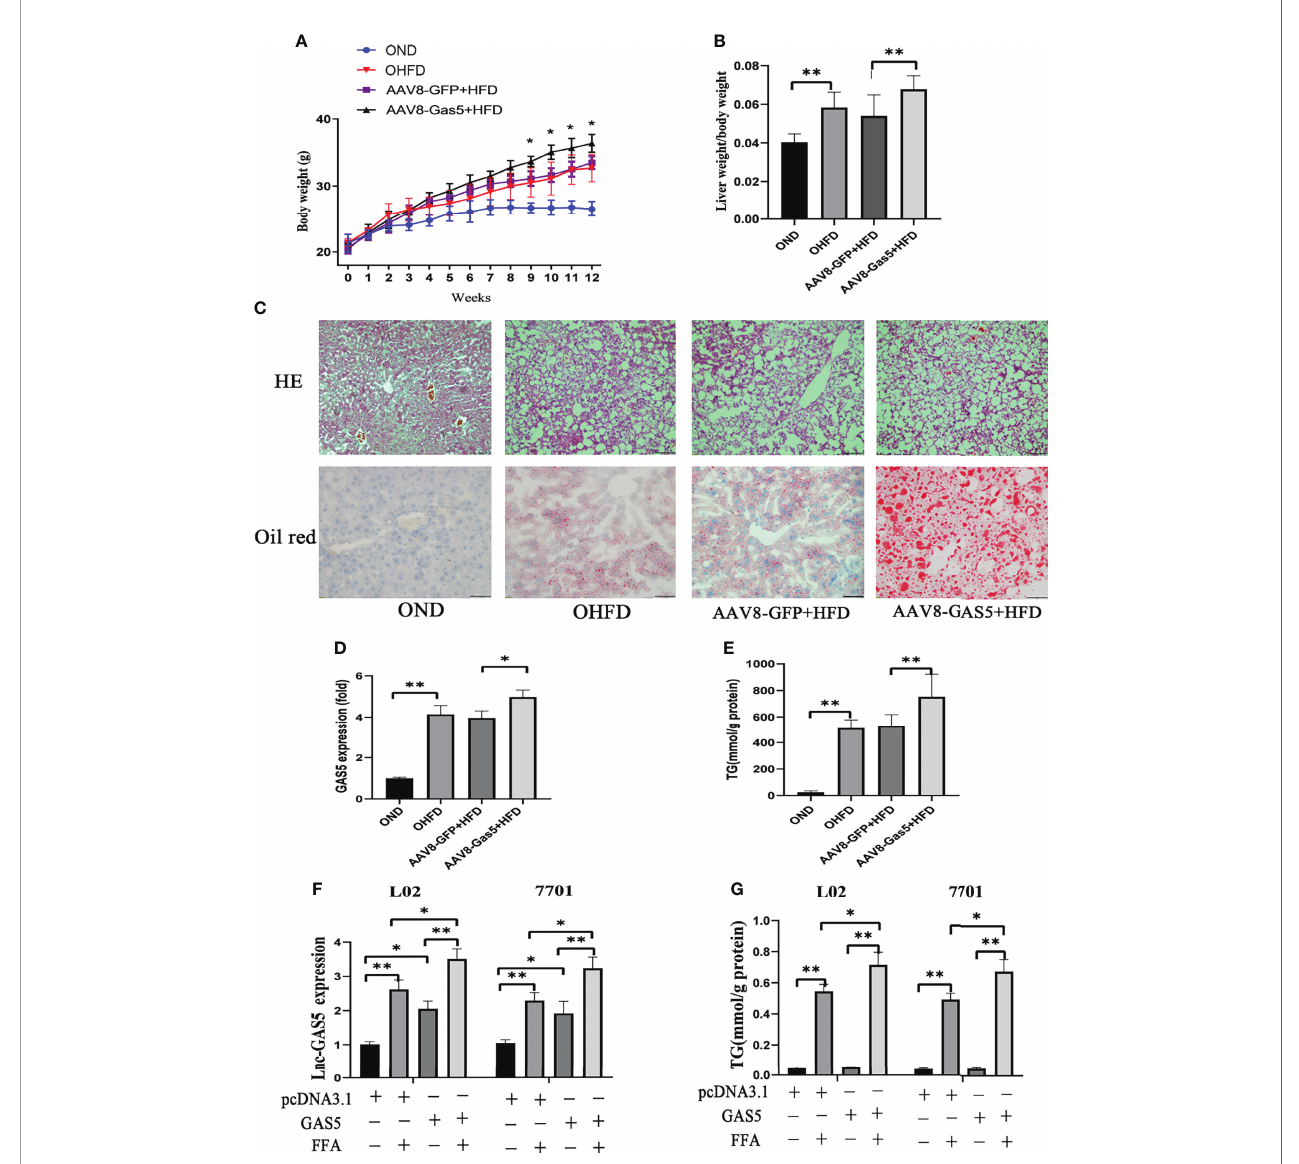
FIGURE 2 | Long non-coding RNA growth arrest speci fi c 5 (GAS5) overexpression aggregates hepatic lipid accumulation. After mice were injected with AAV8-GAS5 or AAV8-GFP for 21 days, they were fed with high fat diet (HFD) or normal chow diet (ND). The body weight of mice in OND, OHFD, AAV8-GFP plus HFD and AAV8-GAS5 plus HFD group was recorded every week (A) , data are expressed as mean ± standard error of mean (SEM), * P < 0.05, n = 7. The ratio of liver weight to body weight in different groups were calculated (B) , data are expressed as mean ± SEM, ** P <0.01, n = 7. The expression of GAS5 in different groups (C) , data are expressed as mean ± standard error of mean (SEM), * P <0.05, ** P <0.01, n = 3. Haematoxylin and eosin staining and oil red staining of liver tissues in different groups (Original magni fi cation, ×200) (D) . The detection of hepatic triglycerides (TGs) in different groups (E) , data are expressed as mean ± SEM, ** P <0.01, n = 7. Cells were transfected with pcDNA3.1-GAS5 (described as GAS5) or pcDNA3.1 vector and treated with free fatty acid. The quantitative real-time polymerase chain reaction analysis of GAS5 in different groups (F) , and the TG detection in different groups (G) ; data are expressed as mean ± SEM, * P < 0.05, ** P < 0.01, n =